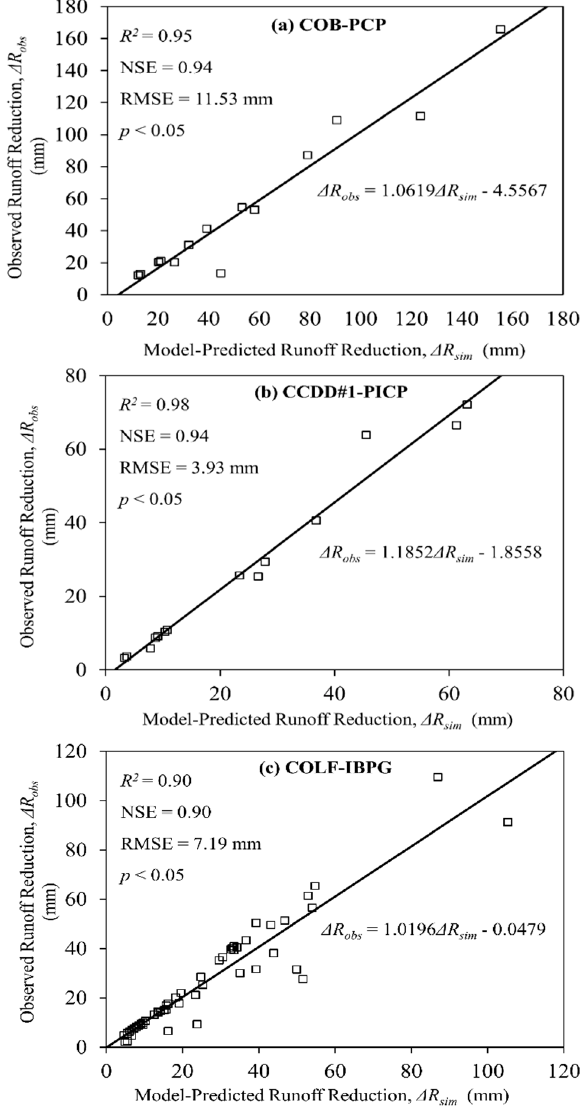
Figure 4. Observed versus WinSLAMM simulated runo ff reduction plots for the calibration of all three types of permeable pavements, ( a ) City of Brownsville (COB)-Porous Concrete Pavement (PCP), ( b ) Cameron County Drainage District#1 (CCDD#1)-Permeable Interlocking Concrete Pavement (PICP), and ( c ) City of La Feria (COLF)-Interlocking Block Pavement with Gravel (IBPG).